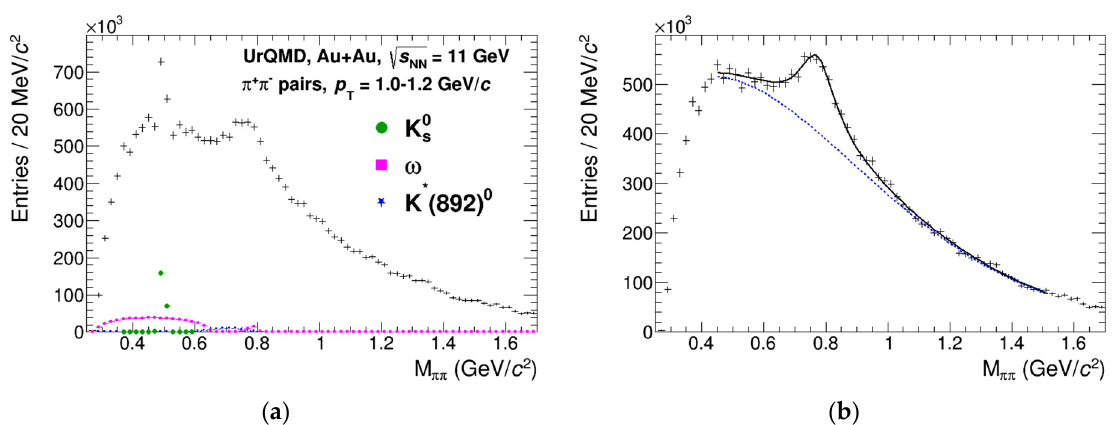
Figure 3. The invariant mass distributions accumulated for π + π− pairs after subtraction of the mixed-event background in Au + Au collisions at √ s NN = 11 GeV in the momentum range 1.0–1.2 GeV/ c . The distributions are shown before ( a ) and after ( b ) subtraction of peak-like contributions from 𝐾 𝑠0 → π + π − , ω → π 0 π + π − , ω → π + π − and K*(892) 0 → π ± K ± decays.